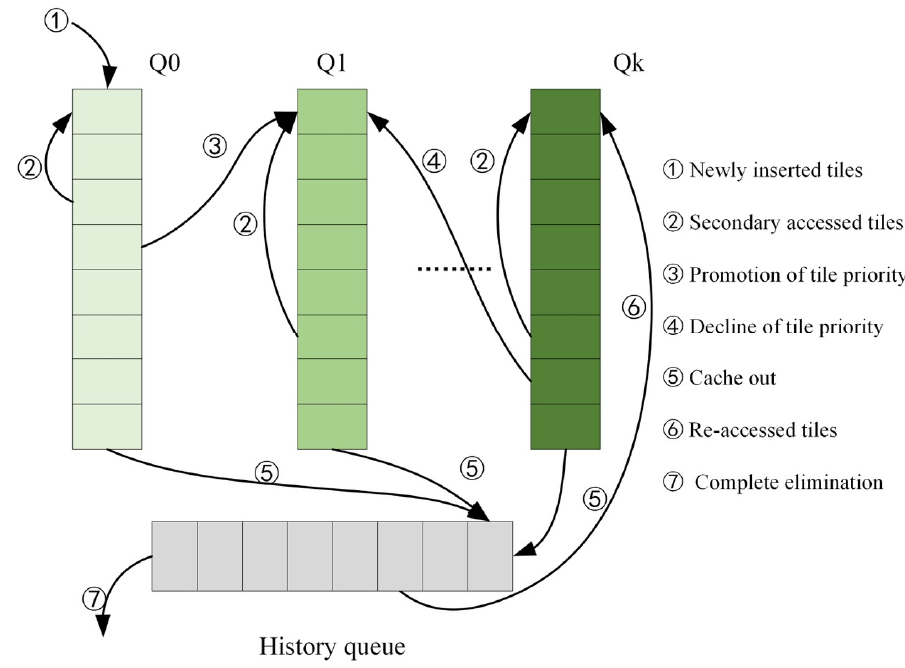
Figure 7. Multi-queue LRU replacement process.